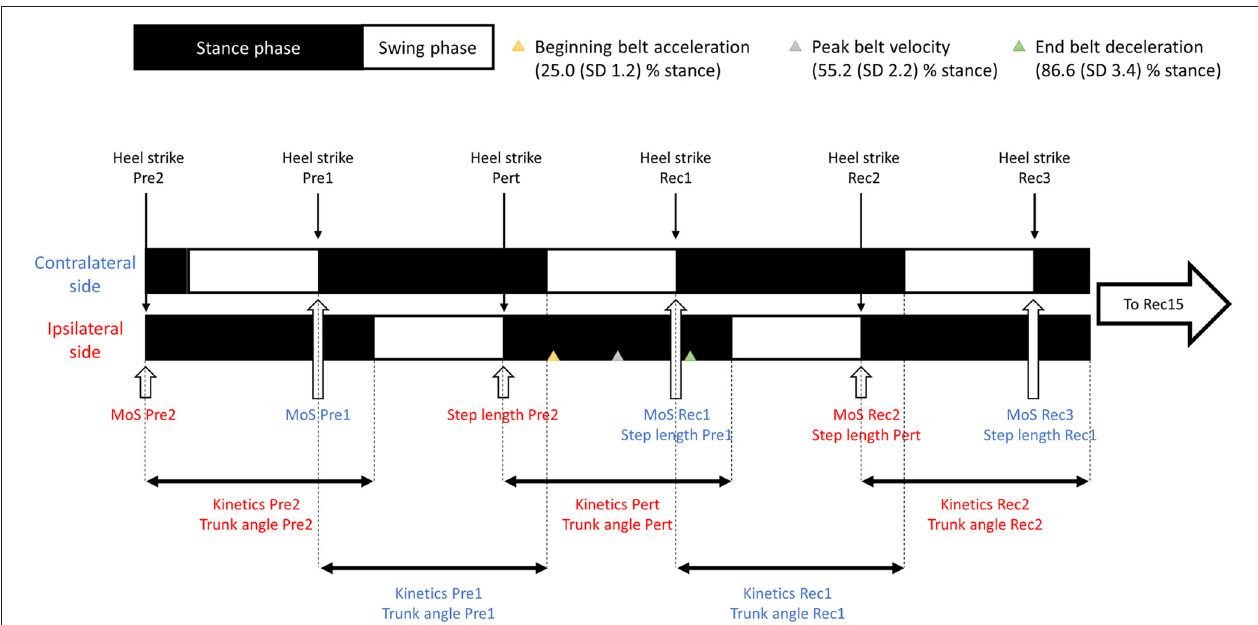
FIGURE 1 | Diagram of steps and outcome measures. In red: outcome measures from the ipsilateral side to the perturbation; in blue, outcome measures from the contralateral